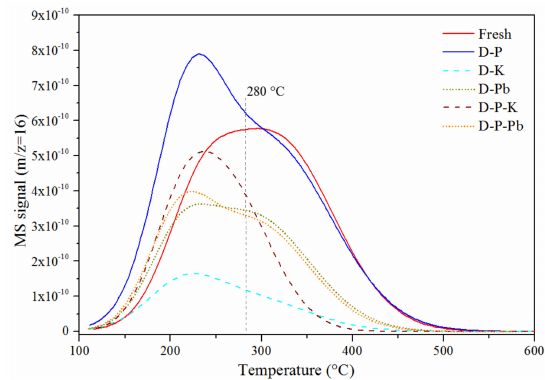
Figure 3. NH 3 -TPD profiles of fresh and poisoned catalyst samples.